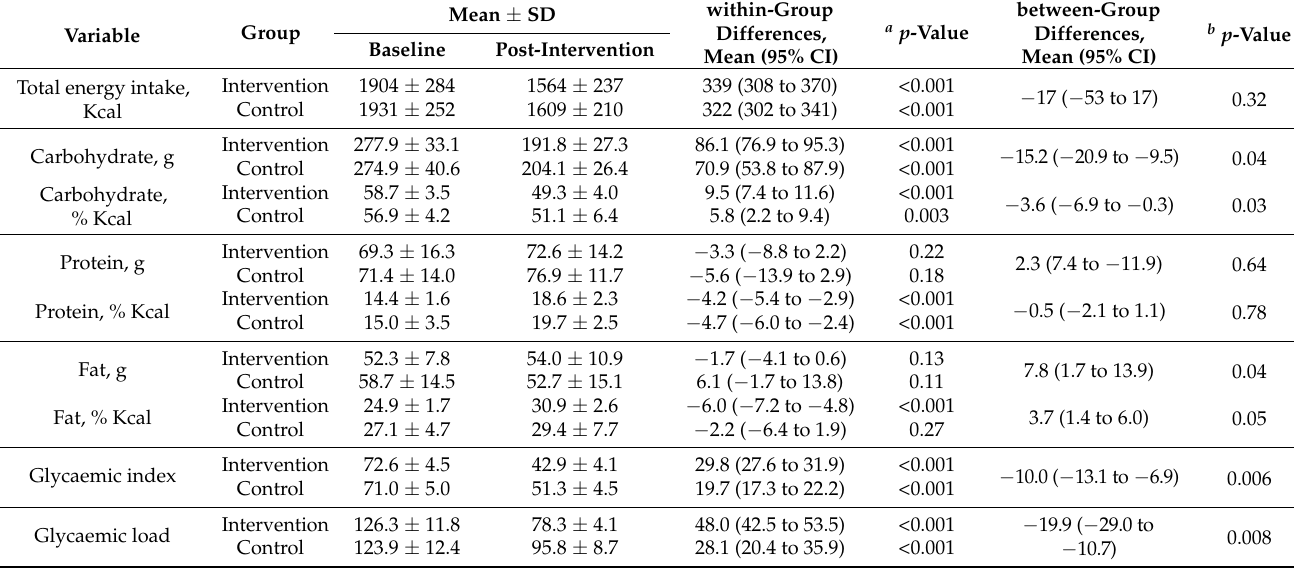
Table 4. Dietary intake at baseline and